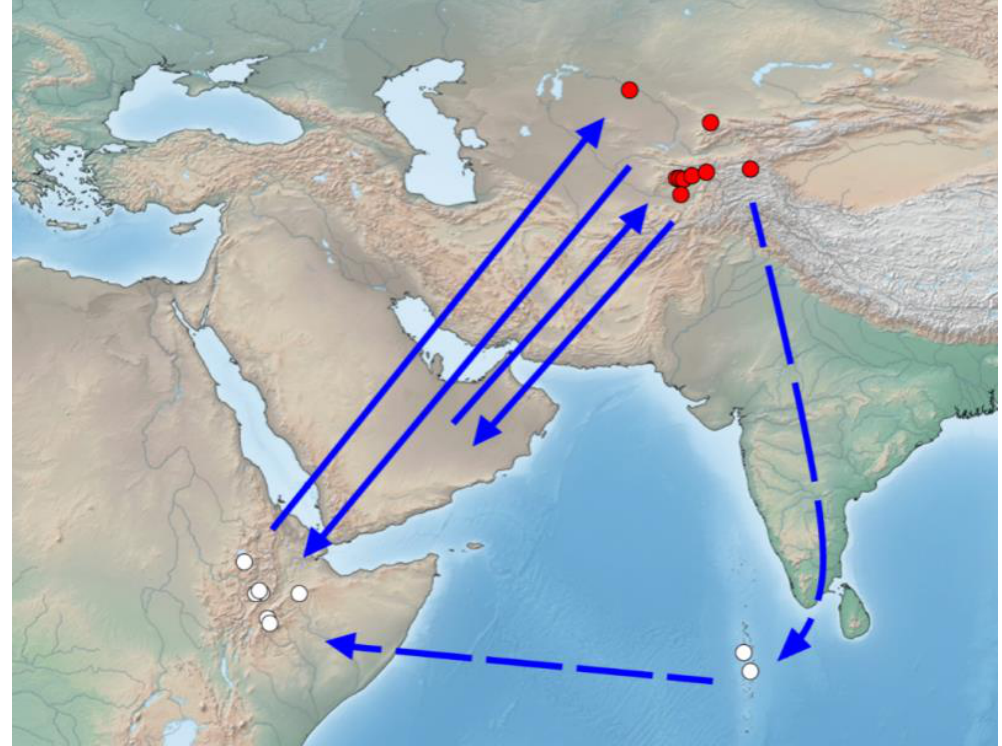
Figure 4. Supposed migrations of Pantala flavescens in the Afro-Asian region. Red dots indicate collection sites of P. flavescens in Middle Asia. White dots indicate collection sites of aboriginal dragonflies (sampled in this study) and butterflies [23] in East Africa, and collection sites of P. flavescens migrating through the Maldives archipelago [9].